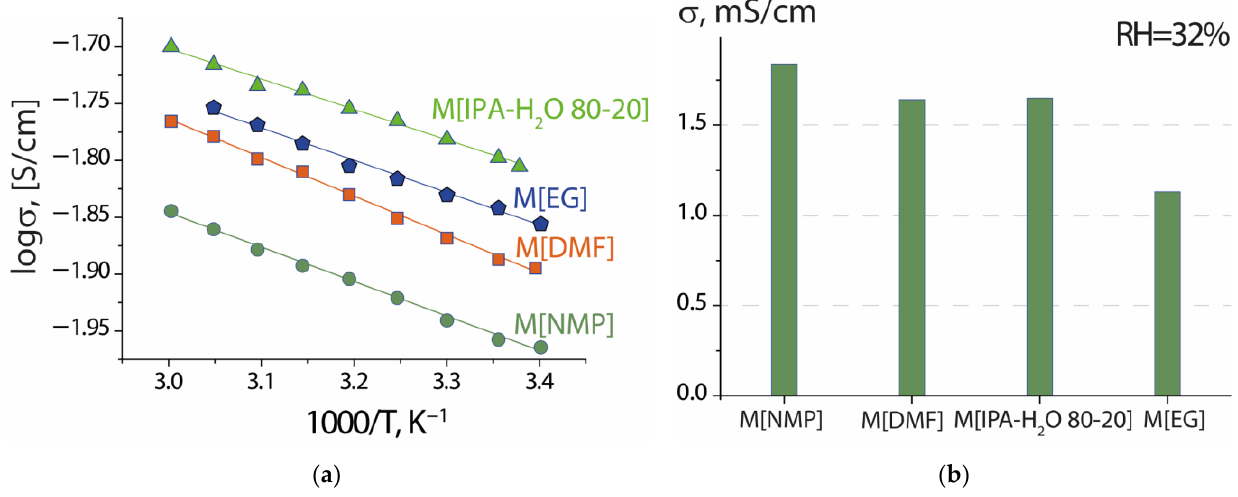
Figure 5. Temperature dependence of proton conductivity measured in contact with water ( a ) and at 25 °C and RH = 32% ( b ) of the studied membranes.